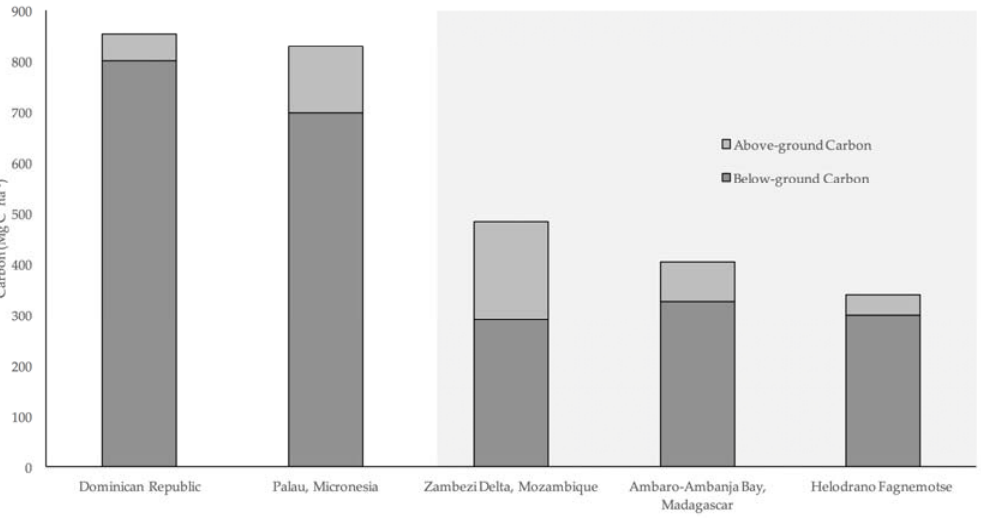
Figure 10. Ecosystem carbon densities up to a soil depth of 1 m reported for carbon inventories in the Dominican Republic [62], Palau, Micronesia [63], the Zamezi Delta, Mozambique [26], Ambaro‐Ambanja Bay, Madagascar [25] and Helodrano Fagnemotse from this study. Grey shading indicates studies in the Western Indian Ocean.